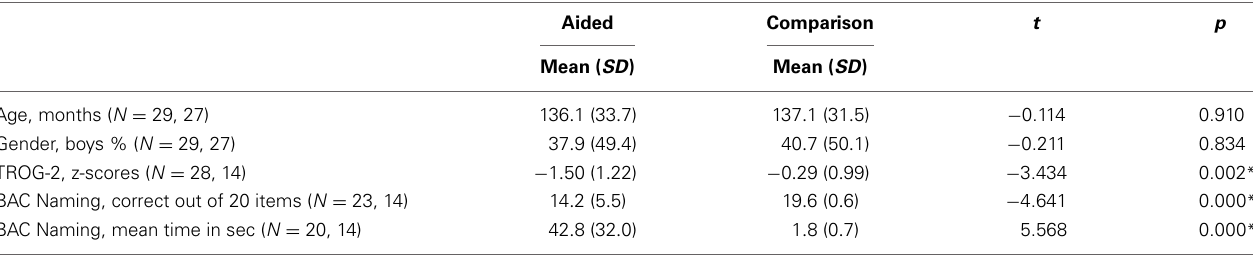
Table 1 | Characteristics of the participants.